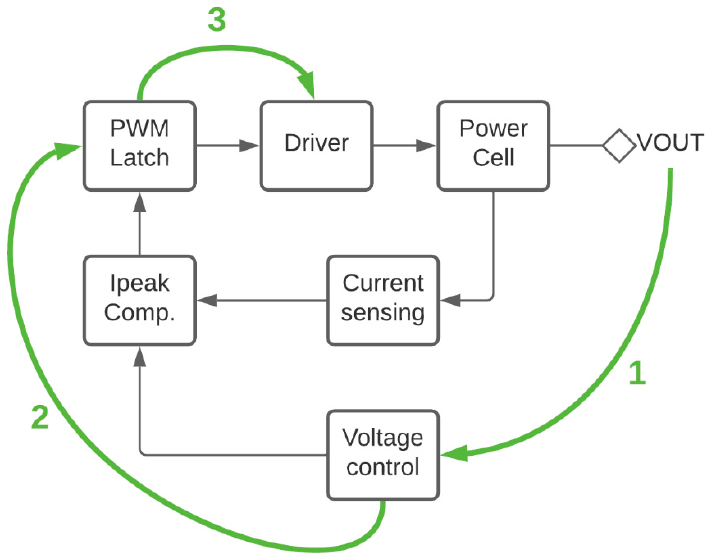
Figure 9. Block diagram explaining compensation of the MOSFET degradation. 3 effects are marked on the diagram: (1) the reduced output voltage is detected by the voltage control block; (2) the correction signal is sent to the PWM generation block; (3) the duty cycle of the MOSFET driver signal is modified.